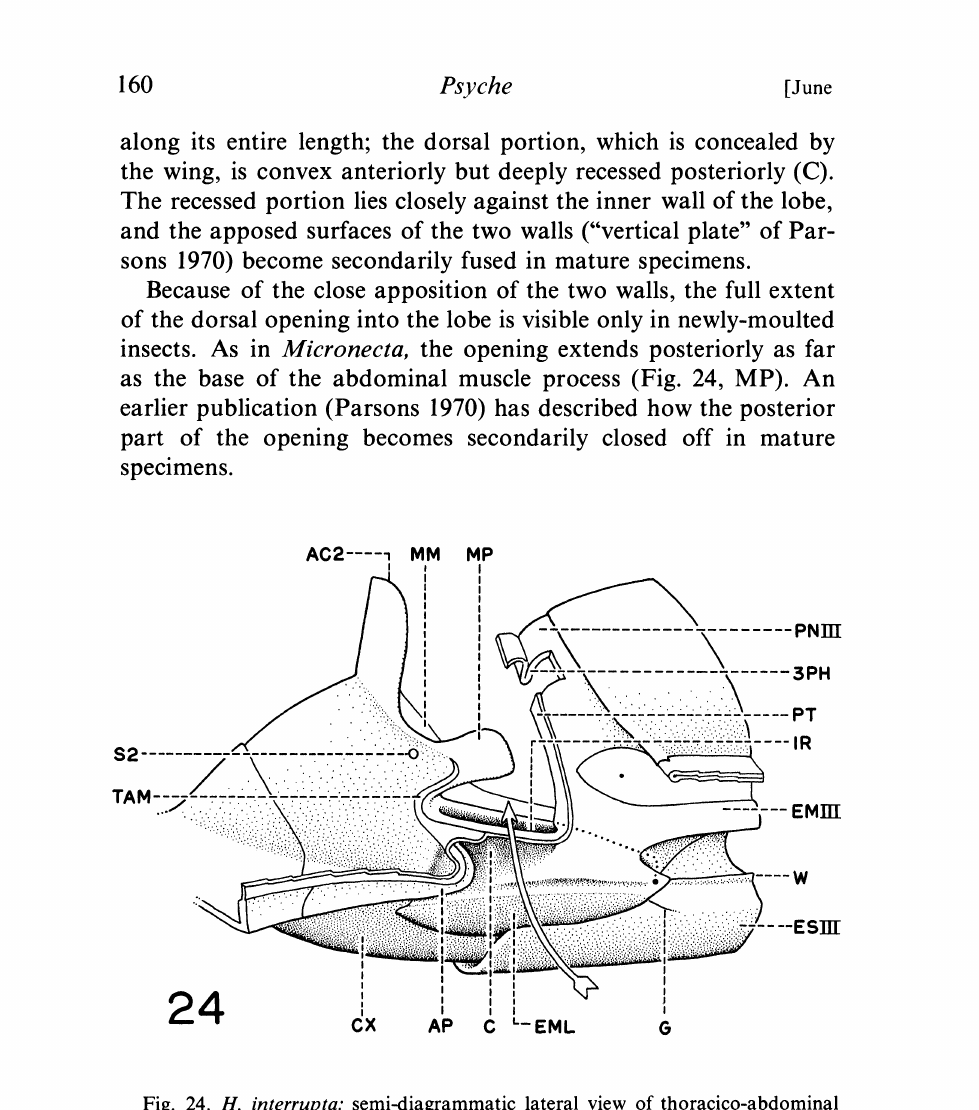
Fig. 24. H. interrupta; semi-diagrammatic lateral view of thoracico-abdominal region, prepared as in Fig. 21. Heavy black dot indicates position of coxal process; heavy dotted line indicates dorsal edge of inner wall of metathoracic epimeral lobe (EML). Head of arrow indicates position of first abdominal spiracle (removed) in thoracico-abdominal membrane (TAM); spiracle communicates with ventral air store (white arrow) and with supra-alar air